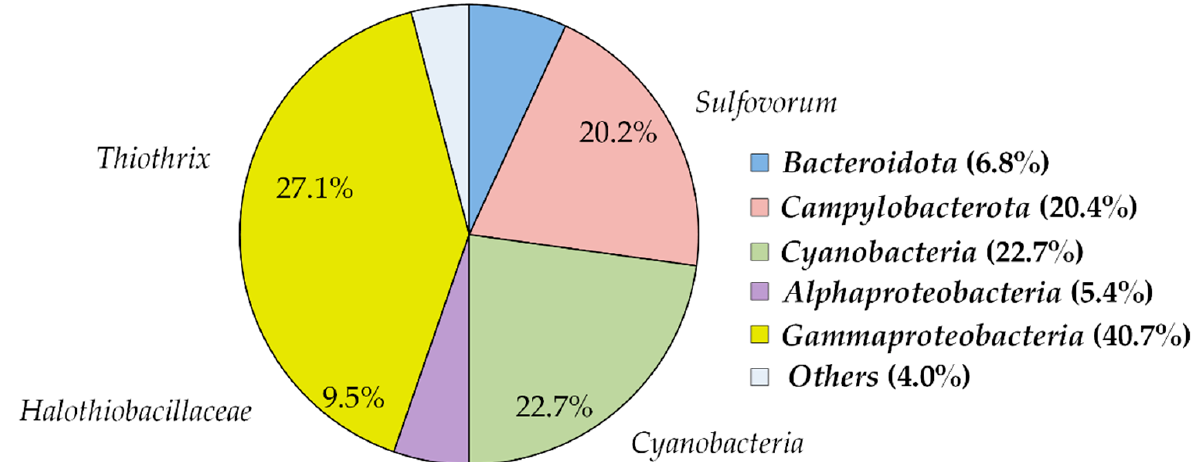
Figure 1. Prokaryotic community composition in “Serovodorodny” spring according to the results of 16S rRNA gene profiling. The community composition is shown at the phylum level, with the exception of Proteobacteria , for which the classes Alpha- and Gammaproteobacteria are shown. The relative abundancies of sulfur-oxidizing groups are shown inside the diagram and highlighted in red.